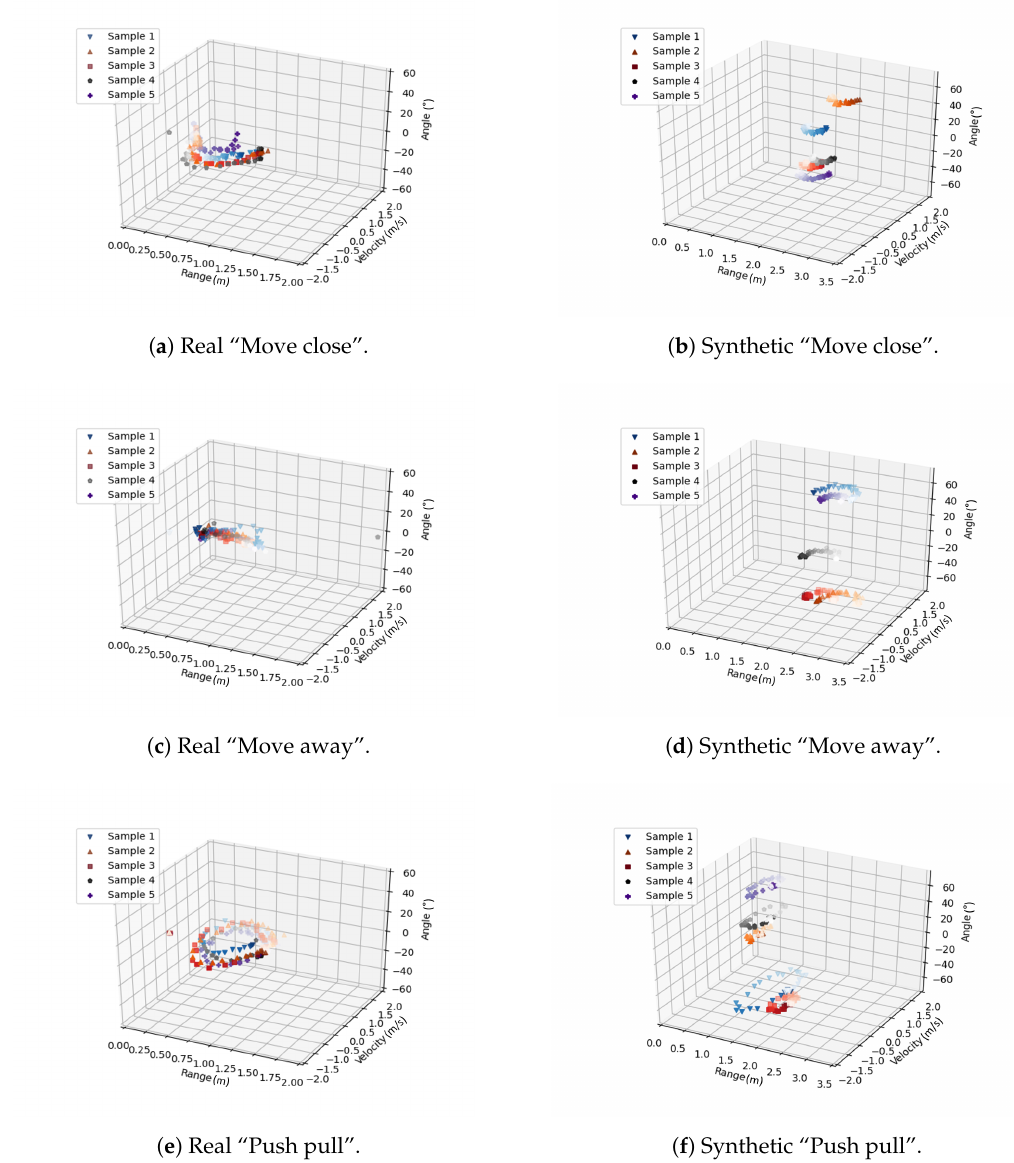
Figure 10. Comparison of “move close”, “move away” and “push